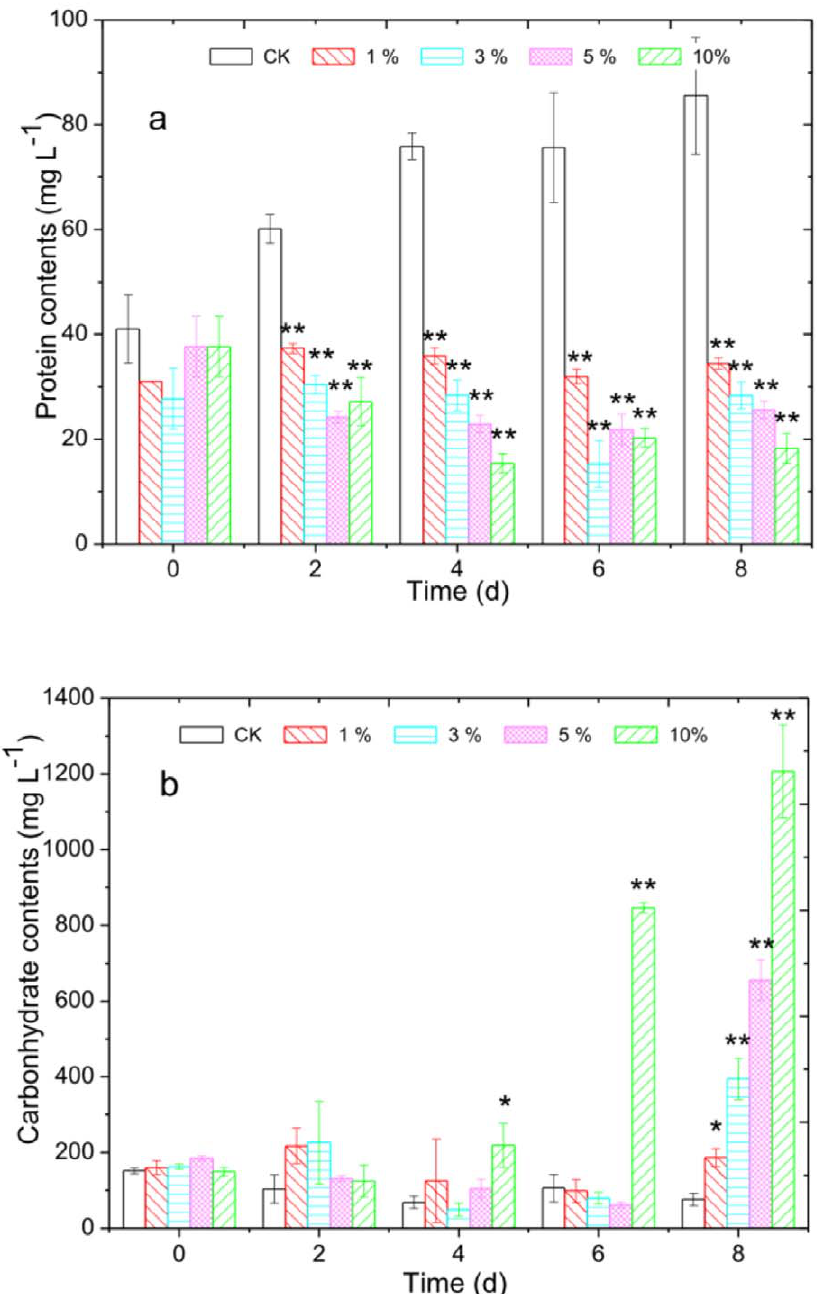
Figure 2. Effect of Streptomyces sp. HJC-D1 culture broth on cyanobacterial protein and carbohydrate contents. (a) protein contents; (b) carbohydrate contents. * represents a statistically significant difference of p , 0.05 when compared to the control, ** represents a statistically significant difference of p , 0.01.